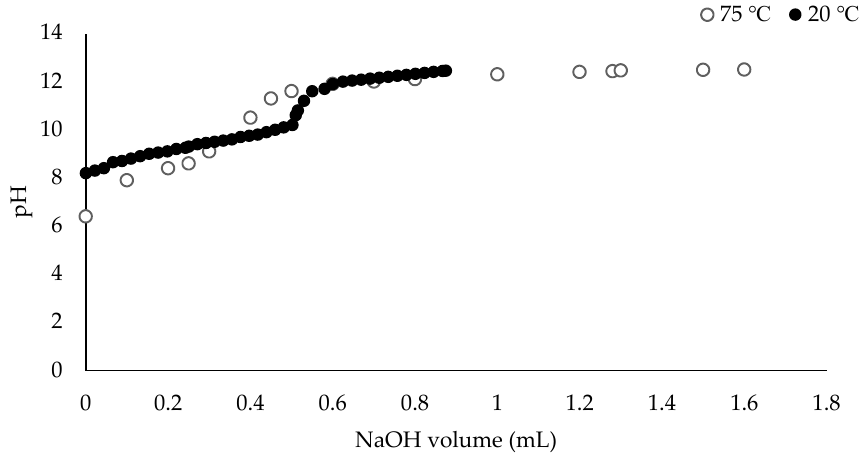
Figure 2. Titration of the same RCWW sample (60 mL) with 30% ( w / v ) NaOH at 20 and 75 °C.